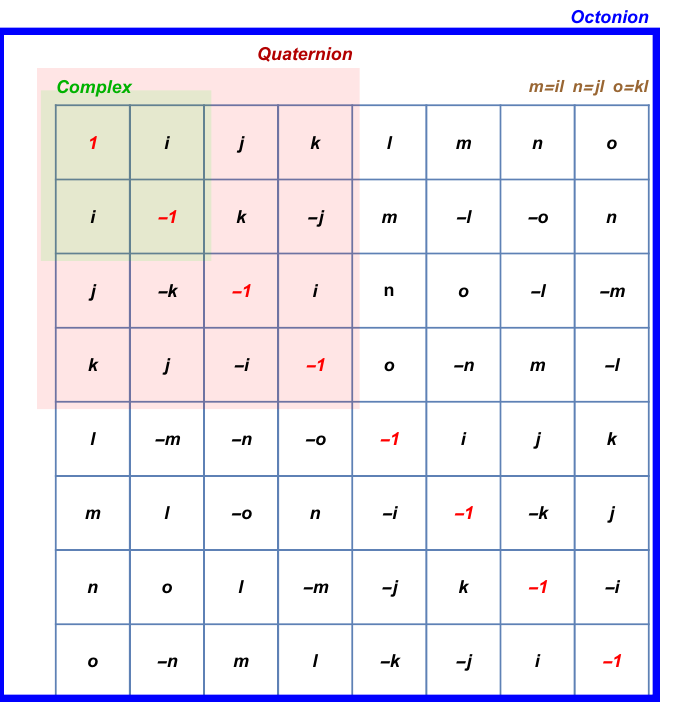
Figure 1. The multiplication rule in the set of